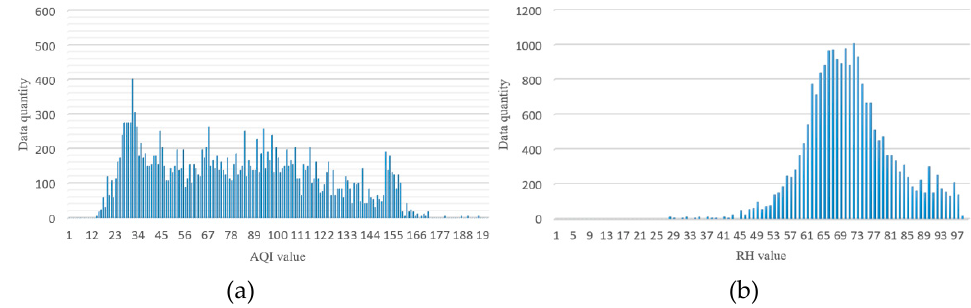
Figure 5. The distribution of AQI and RH values at Renwu Monitoring Station in Kaohsiung, Taiwan; ( a ) AQI value distribution and ( b ) RH value distribution.